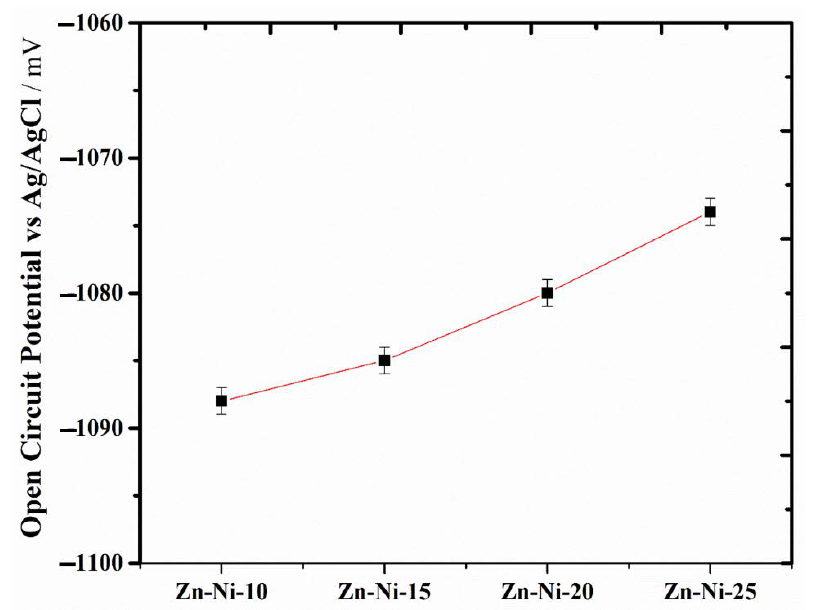
Figure 6. Open-circuit potential trend of the Zn-Ni alloy coatings .